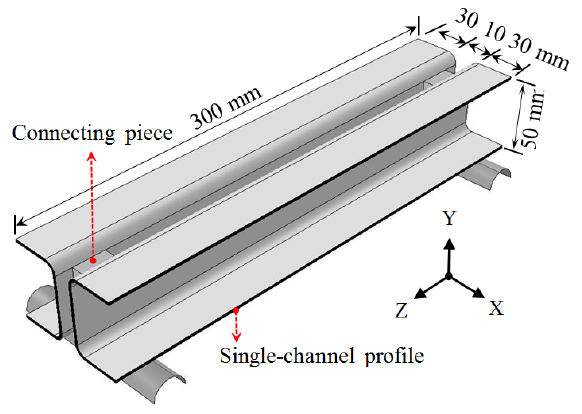
Figure 1: Configuration of CARALL beam with a double-channel cross-section.